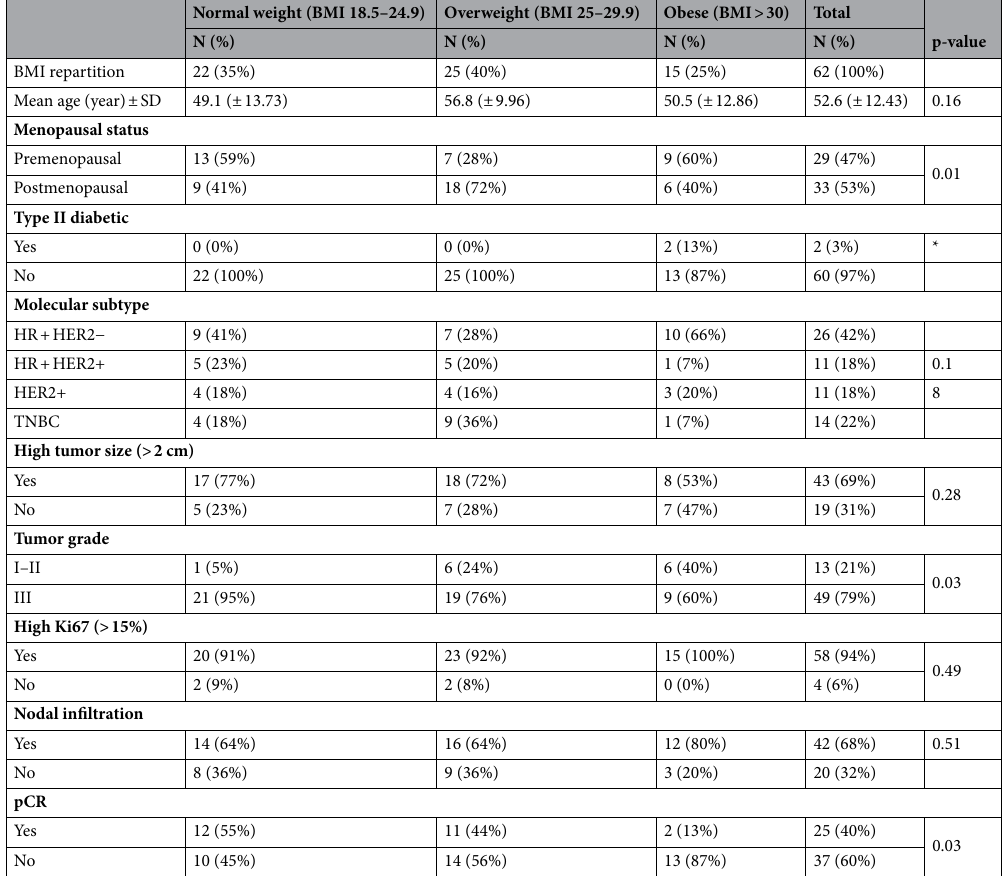
Table 1. Clinical characteristics of patients based on BMI category (N = 62). BMI Body-mass index, SD standard deviation, pCR pathological complete response, HR hormone receptor, TNBC triple negative breast cancer. Anova one-way analysis for mean age, Chi square test for other parameters. P-values are annotated. *Too few parameters to perform a Chi-square